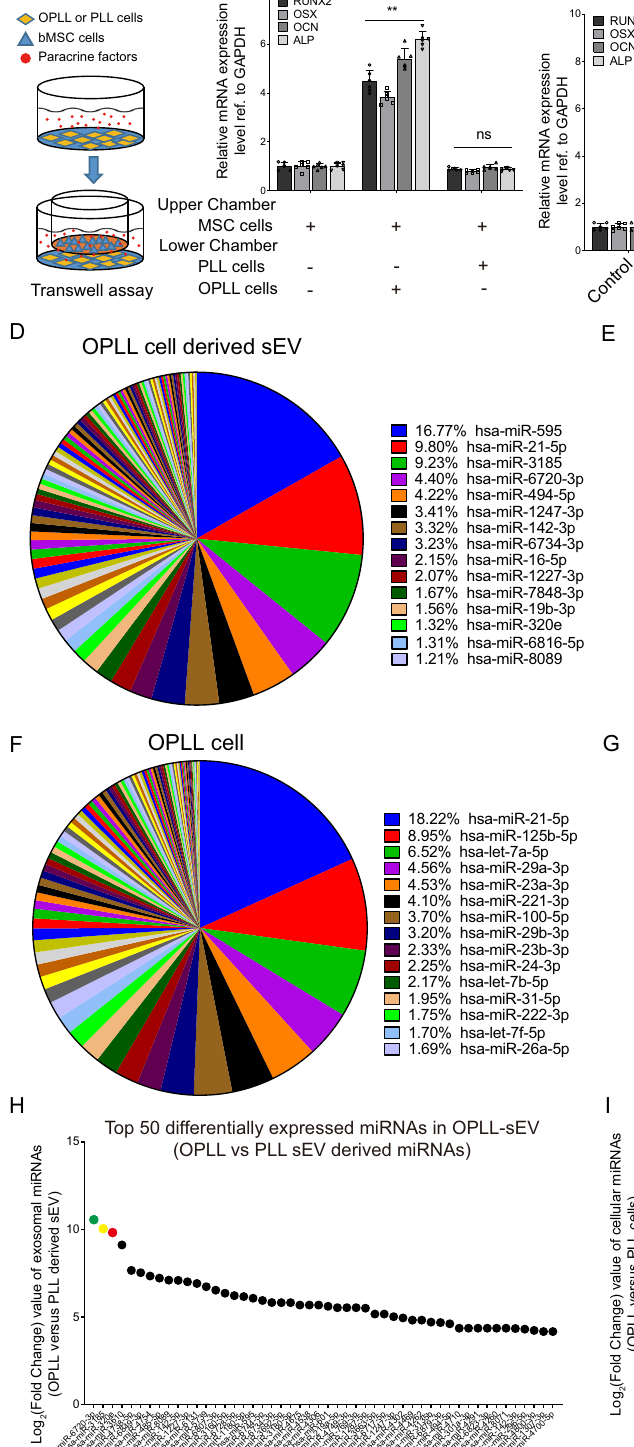
(Fig. 5C, D) but a signi fi cant decrease in the miR-320e inhibition group (Fig. 5E, F). Collectively, these results indicate the possi- bility that miR-320e may play dual roles in regulating both osteoblastogenesis and osteoclastogenesis in the development of OPLL. Interestingly, no signi fi cant differences were found in the miR-10a-3p or NC group, indicating that the effect on osteoclast formation might be miR-320e-speci fi c. NATURE COMMUNICATIONS| (2022) 13:2467